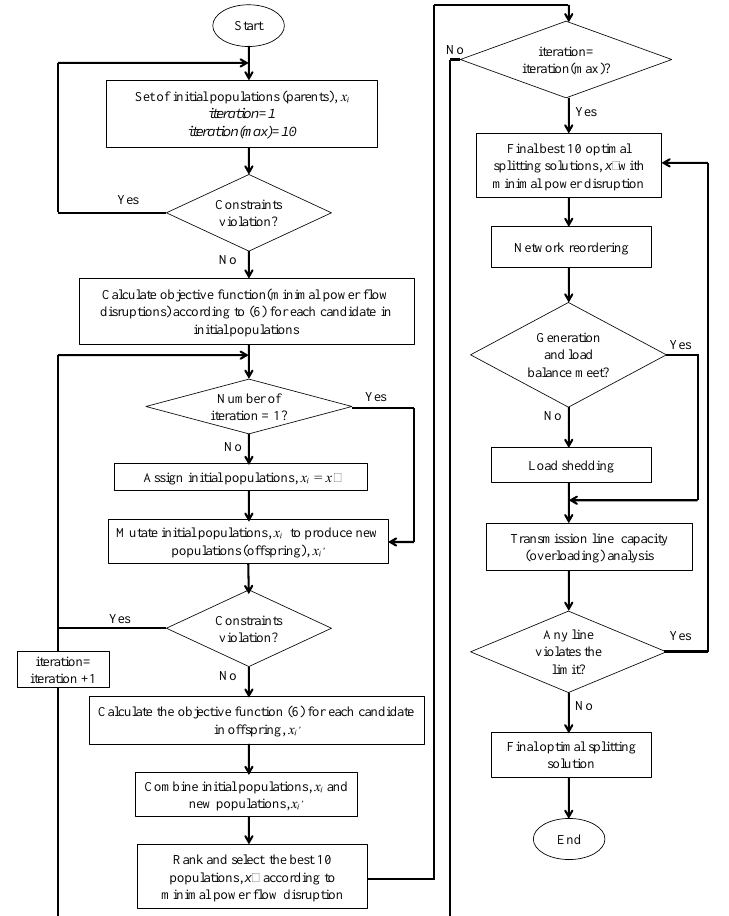
Figure 6. The flowchart for the proposed discrete evolutionary programming (DEP) optimization technique.